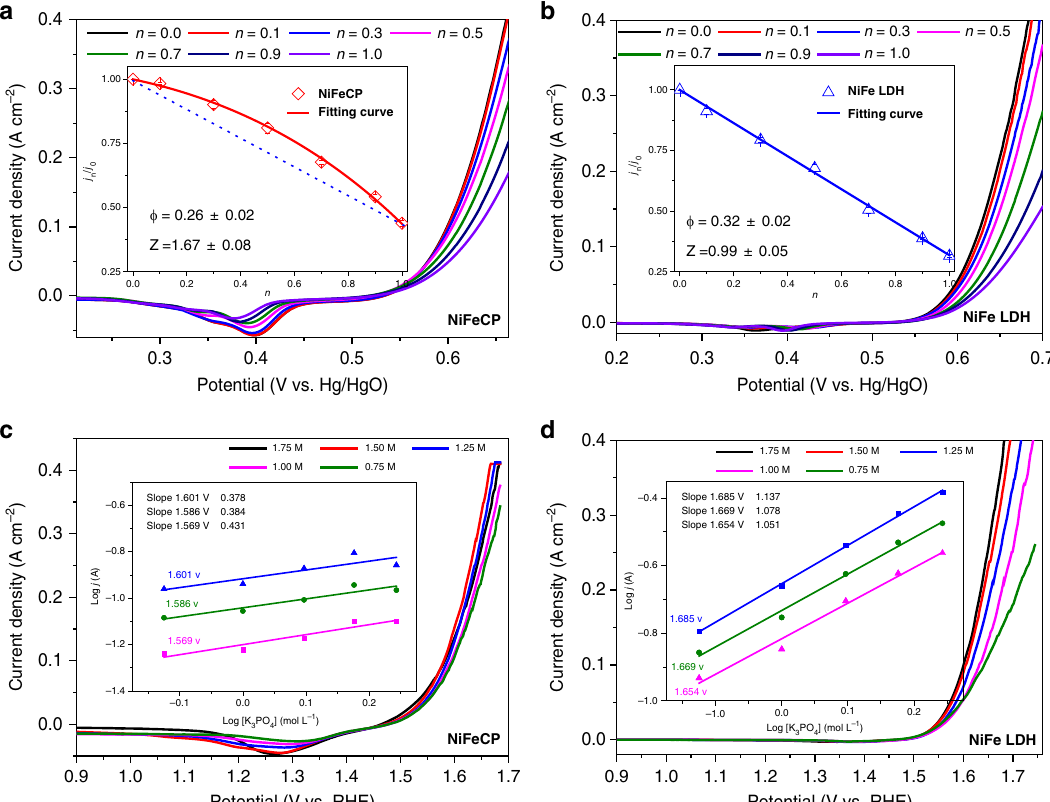
Fig. 7 Proton inventory and atom proton transfer studies. LSV curves of a NiFeCP/NF and b NiFe LDH/NF in mixed solutions of 1.0 M NaOH in H 2 O and 1.0 M NaOD in D 2 O with different ratios as a function of atom fractions of deuterium ( n ). The insets exhibit the plots of j n / j 0 as a function of n , where n = [D]/([D] + [H]) and at a certain potential were abbreviated as j n , j 0 = j H2O (all reported values are averages from 12 different potentials, which can be fi nd in Supplementary Note 3, all errors are given as standard deviations). LSV curves of: c NiFeCP/NF and d NiFe LDH/NF as a function concentration of K 3 PO 4 at pH = 12.65, the insets exhibit the reaction order of [K 3 PO 4